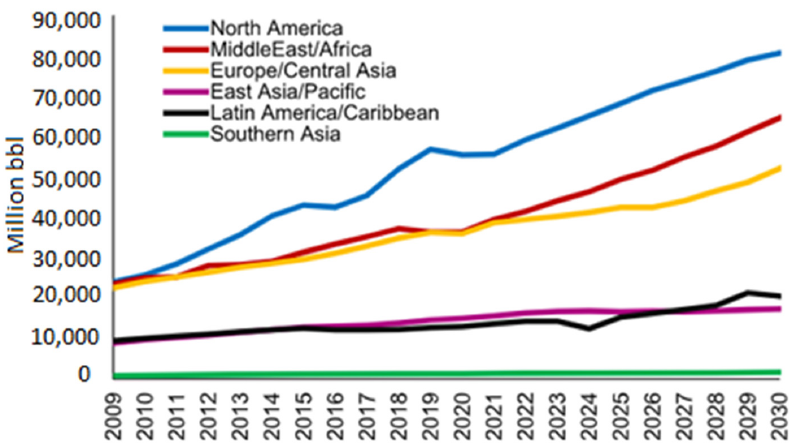
Figure 1. Volume-wise production of produced water by various regions based on literature [5]. Figure 1. Volume ‐ wise production of produced water by various regions based on literature [5]. Figure 1. Volume ‐ wise production of produced water by various regions based on literature [5]. Figure 1. Volume ‐ wise production of produced water by various regions based on literature [5].